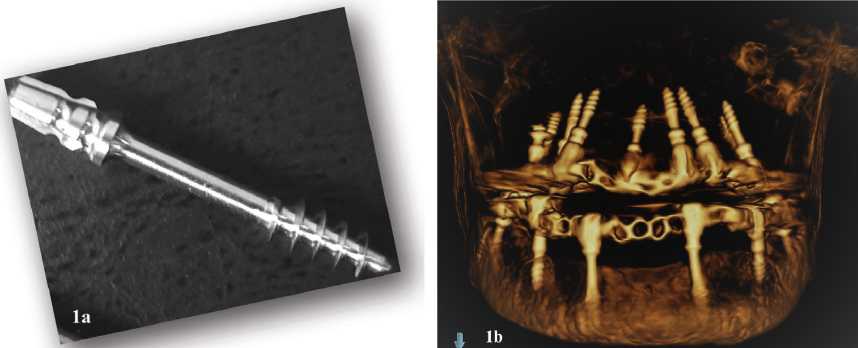
Figure 1: (a) BCS ® basal implant design. (b) A three-dimensional cone-beam computed tomography image shows the anchorage of the BCS ® implants within the basal bone in patients presented with a severely resorbed alveolar